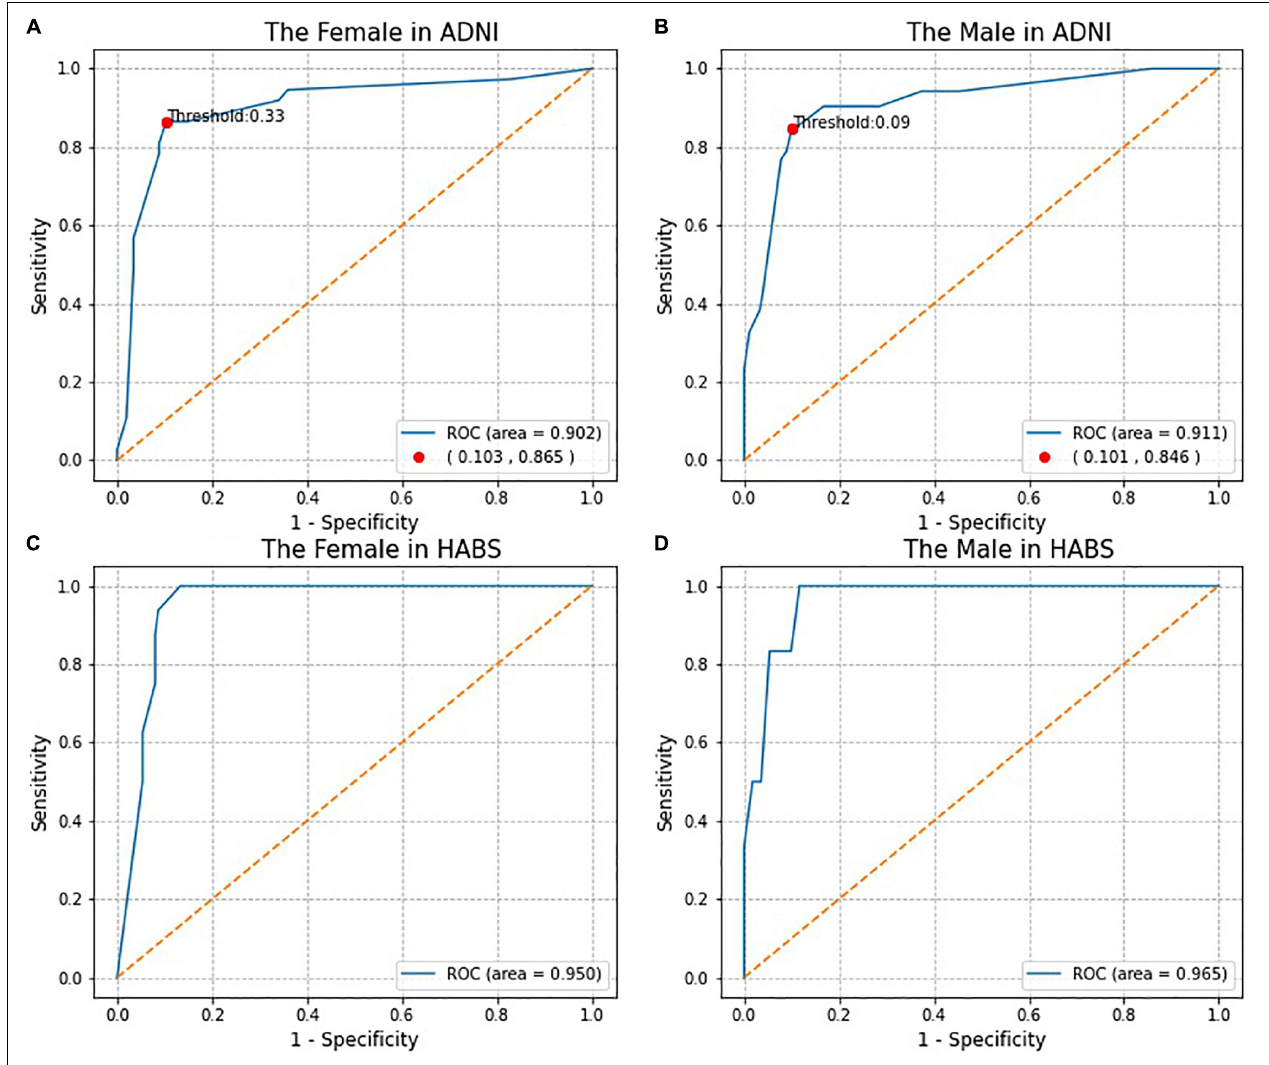
FIGURE 3 | The Receiver operating characteristic (ROC) curves and the Marking of high and low risk